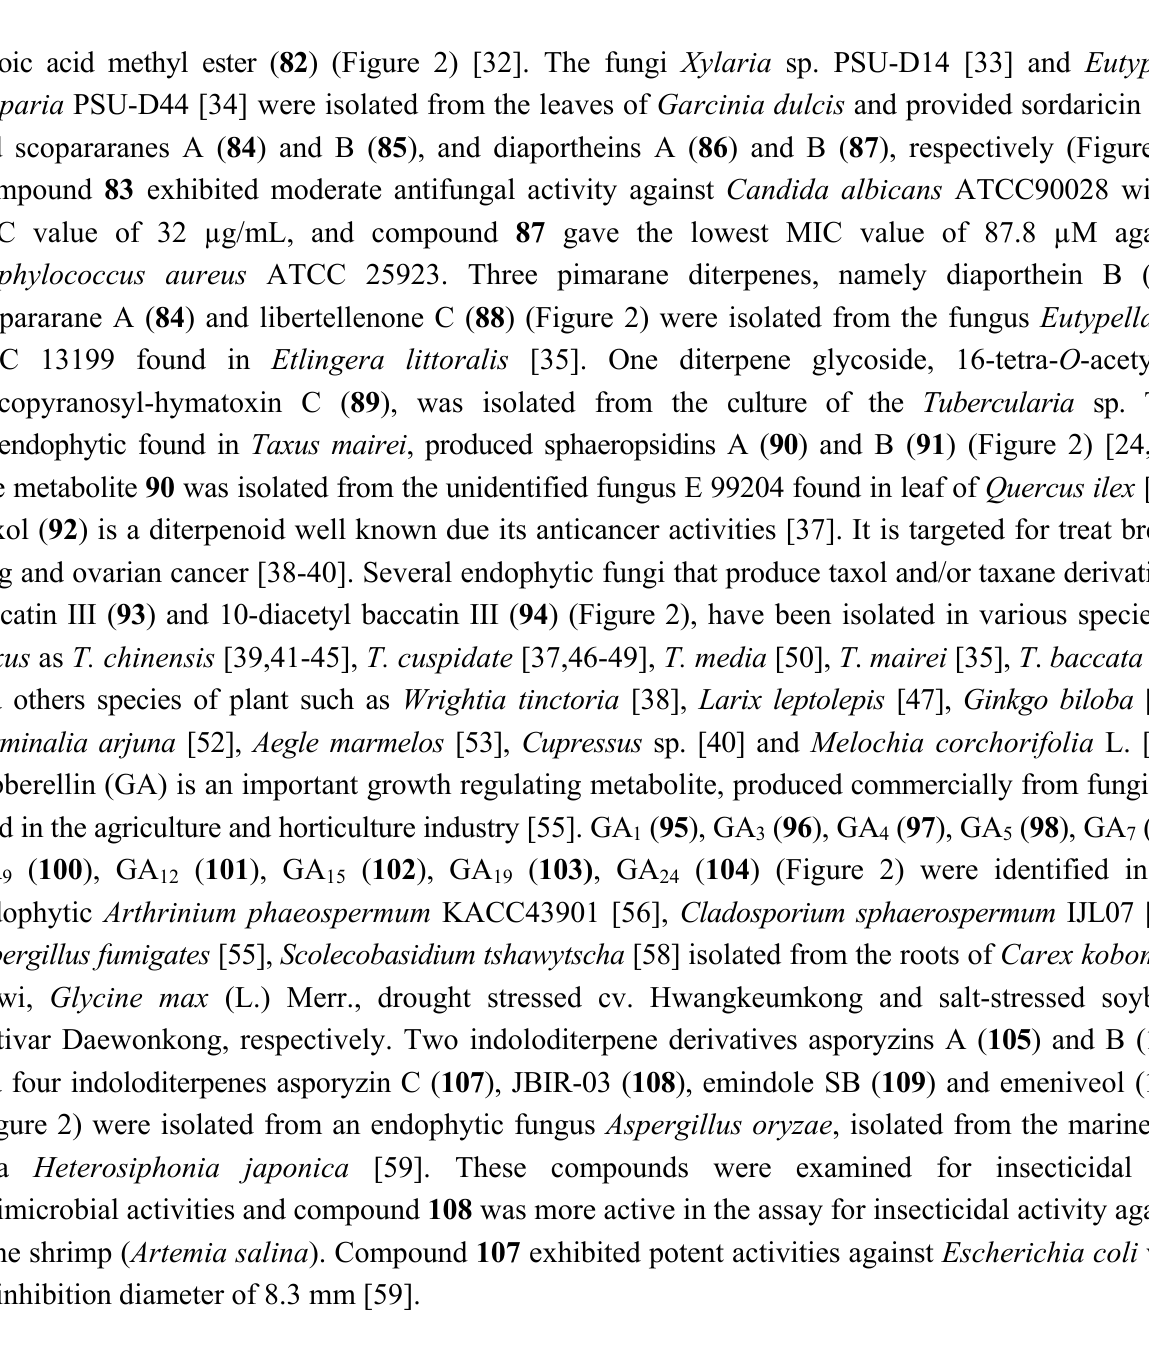
Figure 2. Chemical structures of diterpenes from endophytic